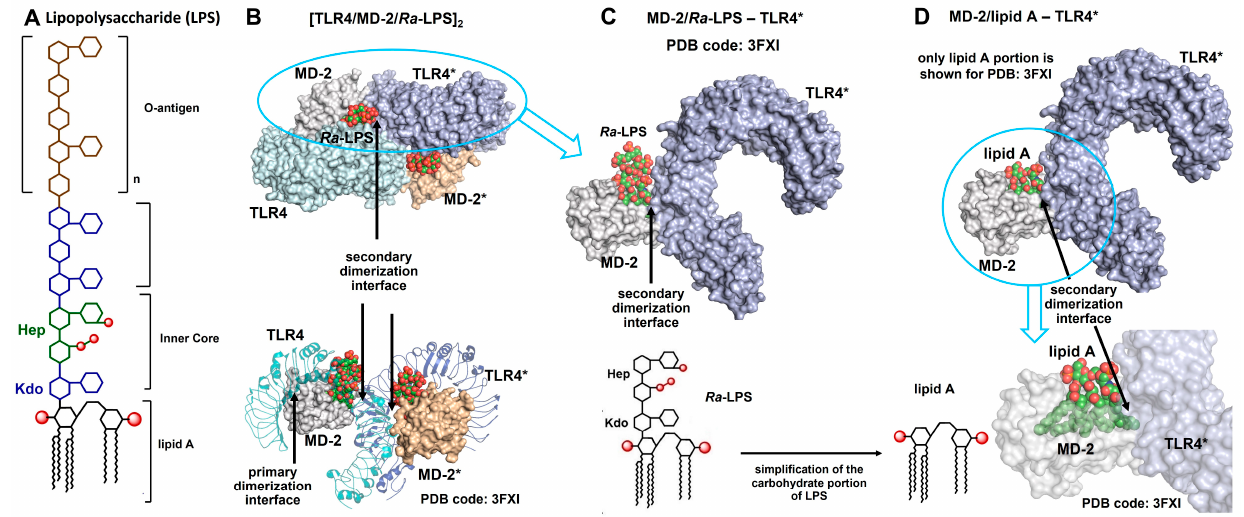
Figure 1. LPS-induced TLR4 complex dimerization. ( A ) Schematic representation of LPS; ( B ) crystal structure of TLR4/MD-2/LPS complex, PDB code: 3FXI; ( C ) formation of a secondary dimerization interface between TLR4/MD-2/LPS and the second TLR4* complex; ( D ) positioning of E.coli lipid A in the binding pocket of MD-2 and lipid A participation in the dimerization process. Images were generated with PyMol.